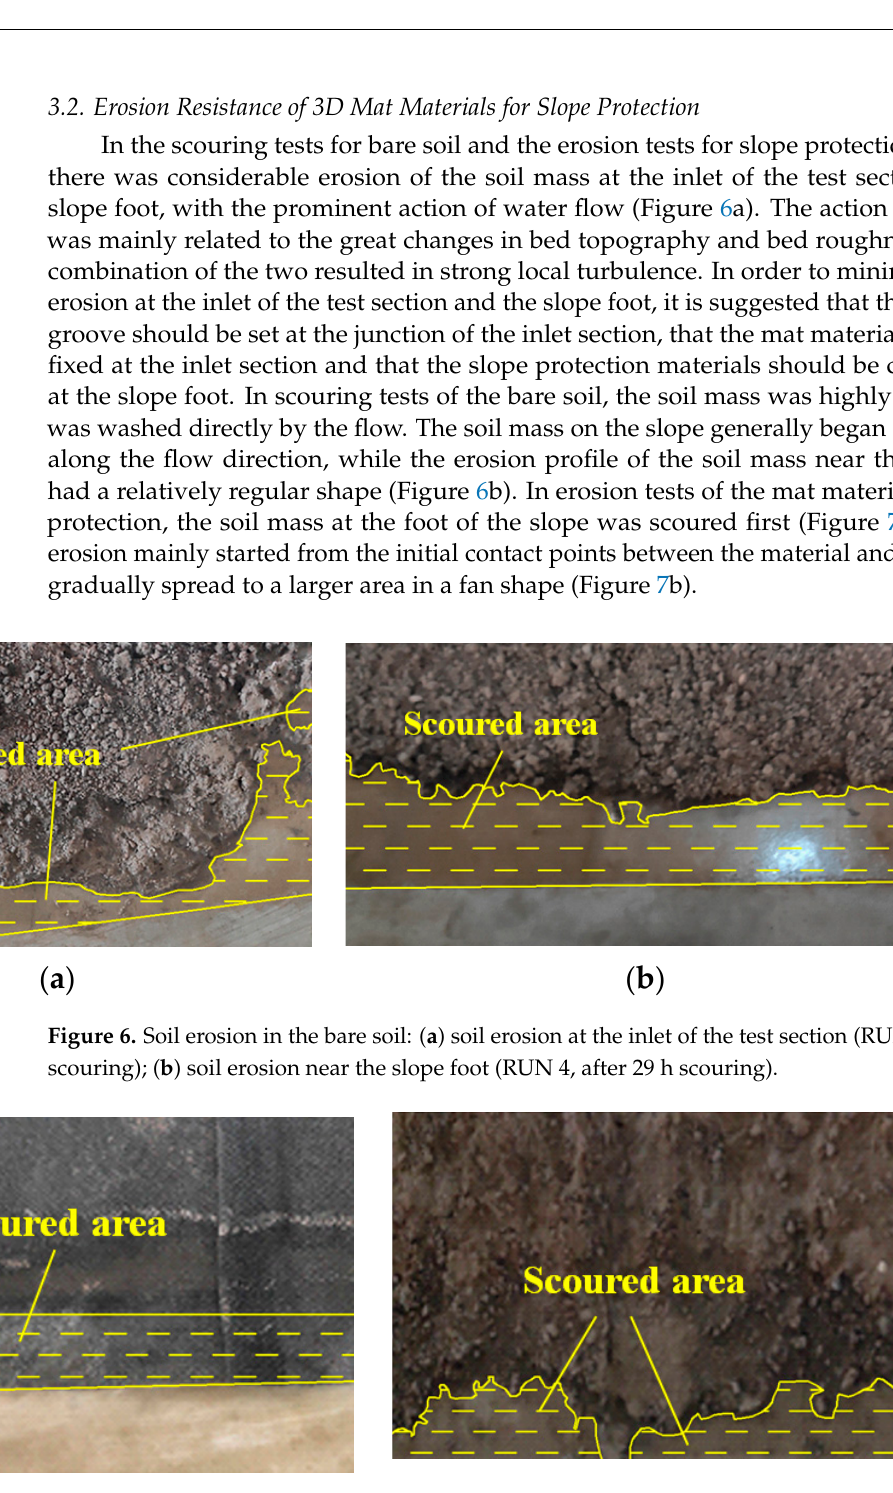
Figure 5. Distribution for turbulent kinetic energy on the vertical lines.